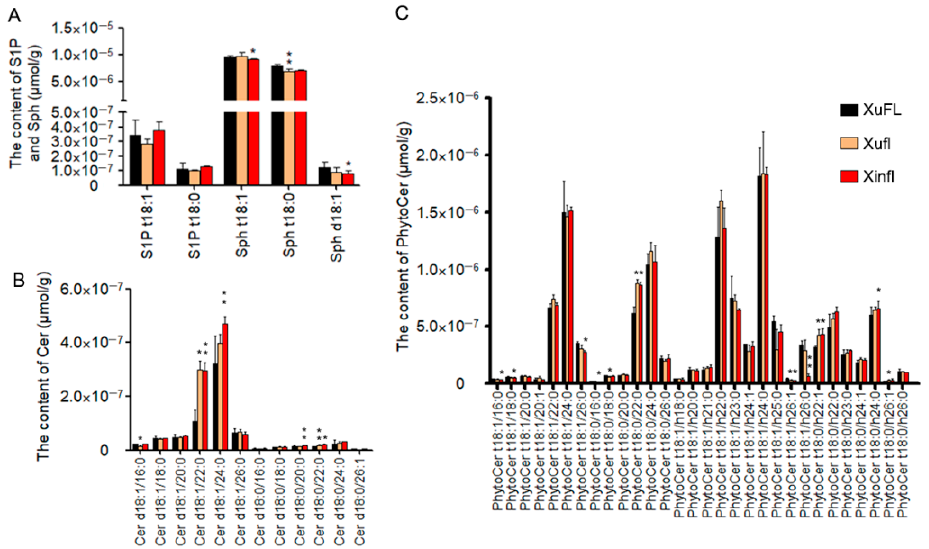
Figure 4. The difference of simple sphingolipid contents in the 0-DPA ovules between wild-type and two mutants. ( A ) The content of various molecular species of Sph and S1P. ( B ) The content of various molecular species of Cer. ( C ) The content of various molecular species of PhytoCer. Sph, sphingosines; S1P, sphingosine-1-phosphate; Cer, ceramides; PhytoCer, phytoceramides. “d18:0/1” indicates that the long-chain bases (LCB) of sphingolipids had two hydroxyl groups (d), 18 carbon atoms, and no or 1 double bond; “t18:0/1” indicates that the LCB had three hydroxyl groups (t), 18 carbon atoms, and no or 1 double bond; “16-26:0/1” indicates that the long-chain fatty acid (LCFA) or very long chain fatty acid (VLCFA) of sphingolipids had 16 to 26 carbon atoms and no or one double bond; and “h16-26:0/1” indicates that the long-chain fatty acid (LCFA) or very long chain fatty acid (VLCFA) of sphingolipids was a hydroxylated fatty acyl (h) and had 16 to 26 carbon atoms and no or 1 double bond. XuFL, wild-type Xuzhou 142; Xufl , Xuzhou 142 lintless-fuzzless mutant; Xinfl , Xinxiangxiaoji lintless-fuzzless mutant. SD represents three biological repeats. Statistical data analysis was performed by the one-tailed student’s t-test. One asterisk and two asterisk indicate significant differences at p < 0.05 and p < 0.01,